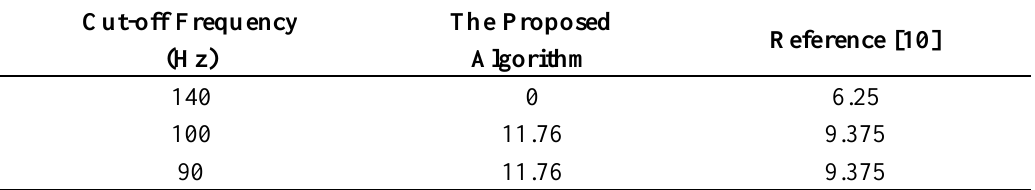
Table 2. Testing results via low-pass filtering attack with various cut-off frequencies.